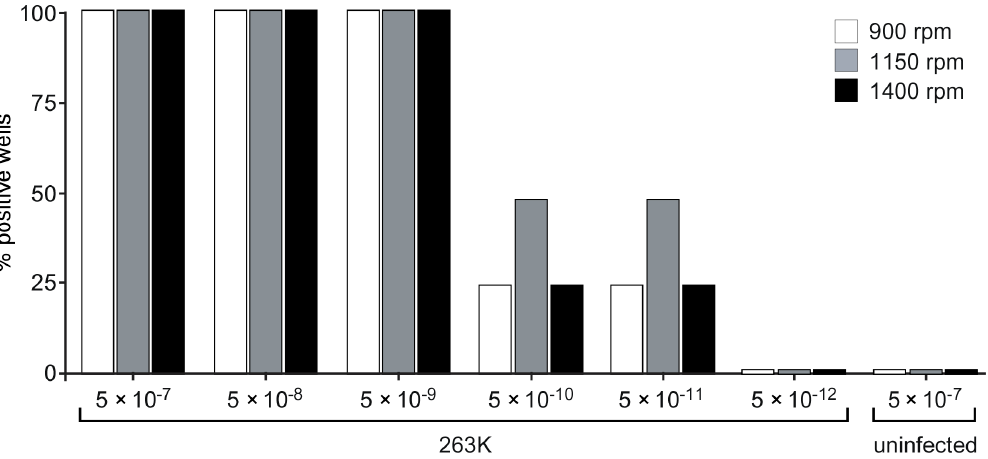
Figure 10. Effect of different orbital shaking conditions (900, 1150 or 1400 rpm) on RT-QuIC sensitivity using an iEMS multi-plate, temperature-controlled shaker incubator. Quadruplicate RT-QuIC reactions were seeded with 2 μ L of scrapie positive (263K) brain tissue dilutions as indicated. Reactions were incubated at 42 °C in an orbital shaking Thermo Scientific (iEMS Incubator/Shaker HT) using Ha rPrP Sen (90–231) as the substrate. After a 17 h incubation, ThT fluorescence was measured in a BMG FLUOstar Omega plate reader using the RT-QuIC read settings described in Materials and Methods. The percentage of positive replicate wells is plotted for each dilution used.